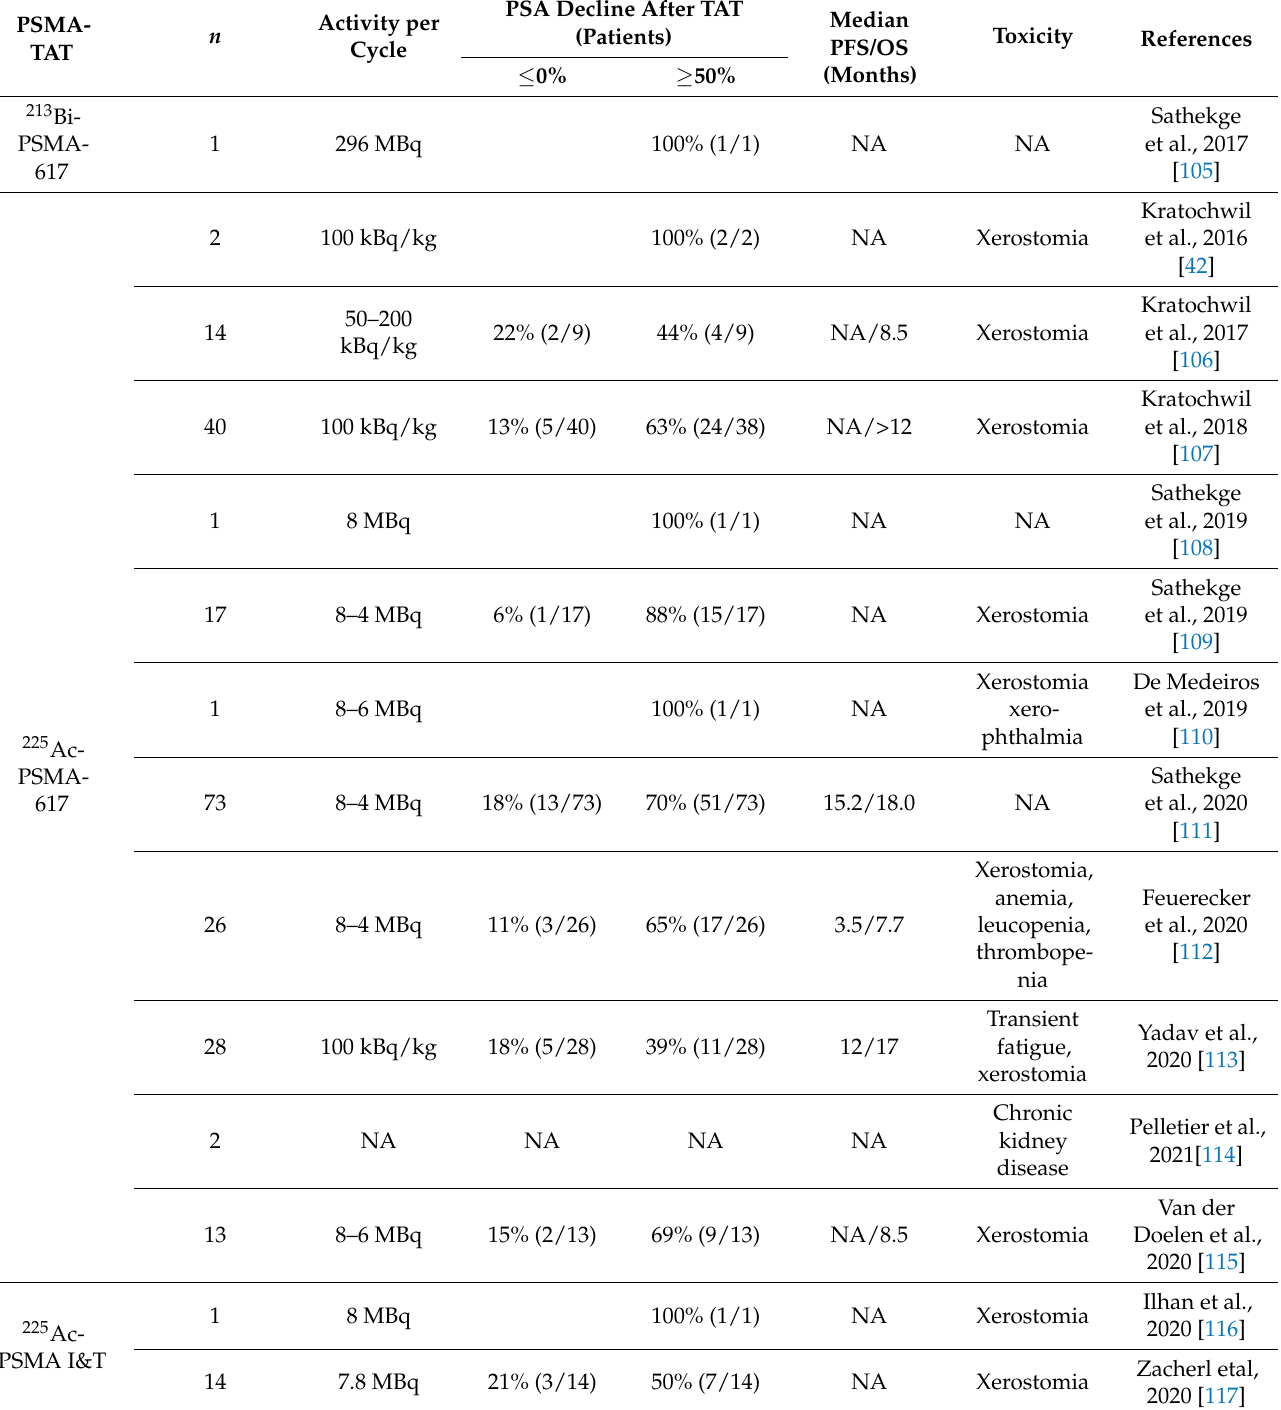
Table 5. Overview of α -emitting radionuclides and PSMA-targeting agents investigated in clinical studies for targeted prostate cancer therapy. n , number of patients; PFS, progression-free survival; OS, overall survival; -, activity de-escalation in subsequent